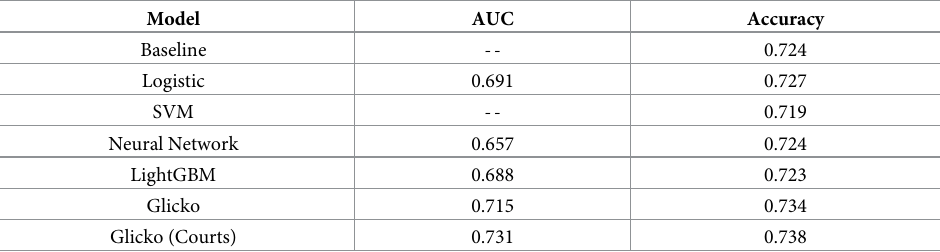
Table 2. Model comparison for ATP single matches (moving window).